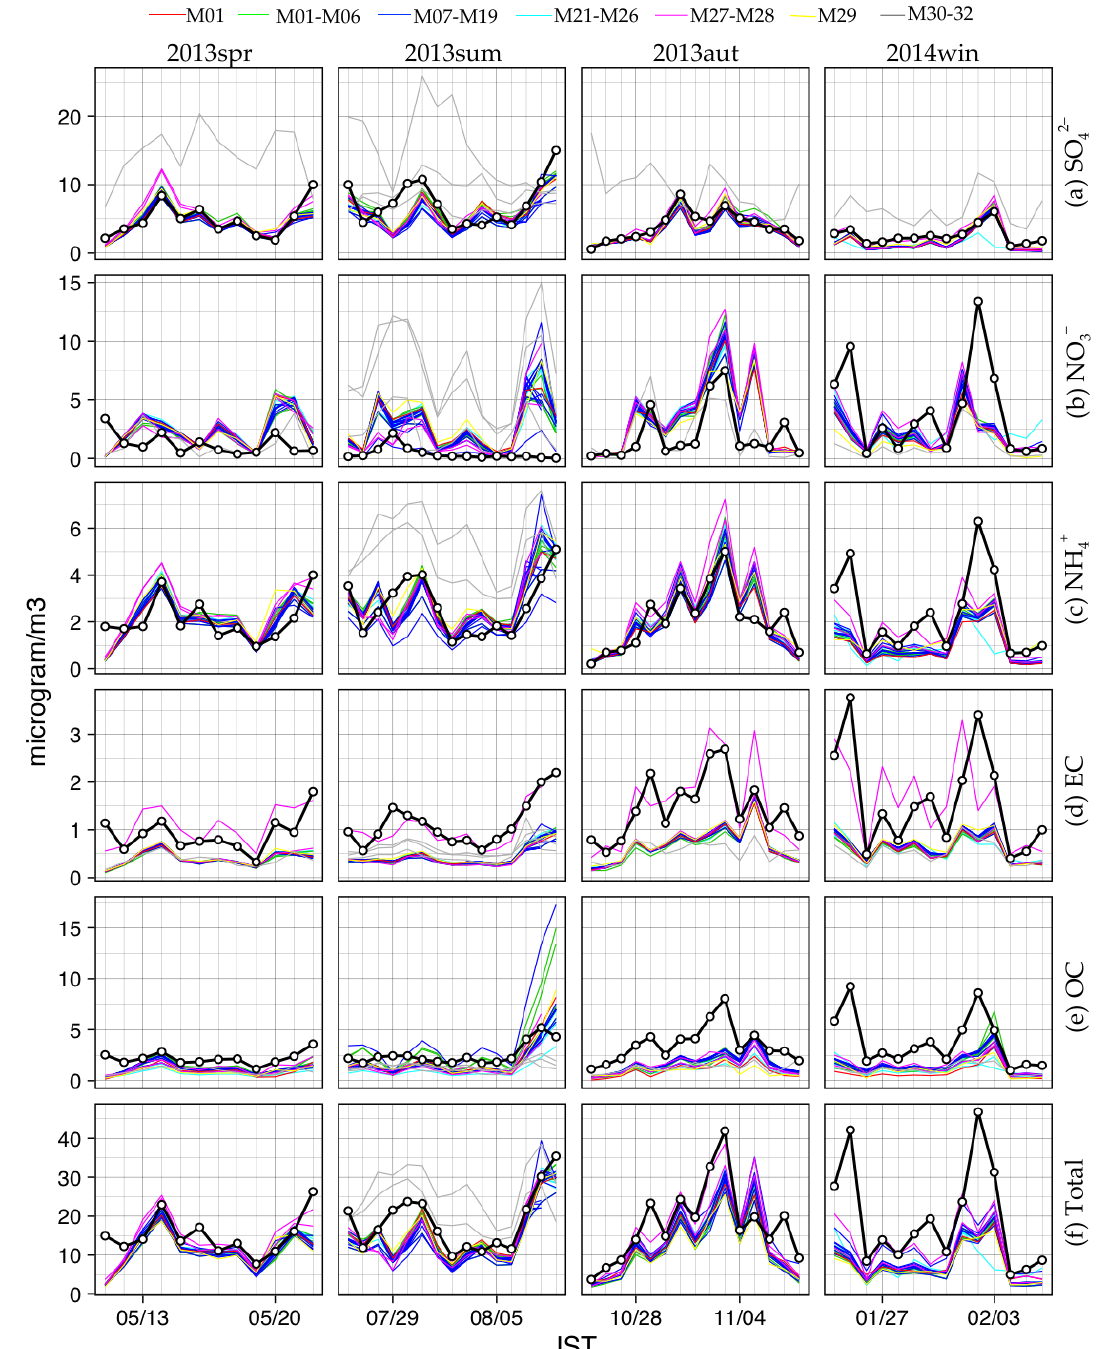
2− , ( b ) NO − , ( c ) NH 4+ , ( d ) EC, ( e ) OC, and 4 3